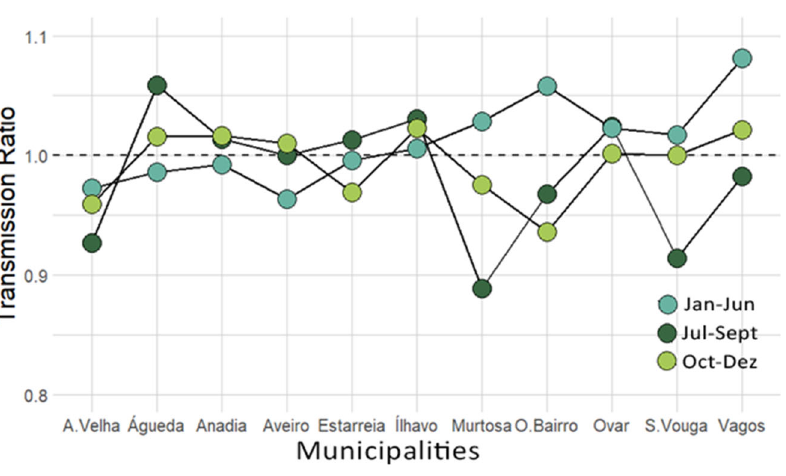
Figure 3. Transmission ratio regarding the municipality data for Jan–Jun, Jul–Sept and Oct–Dec time intervals.